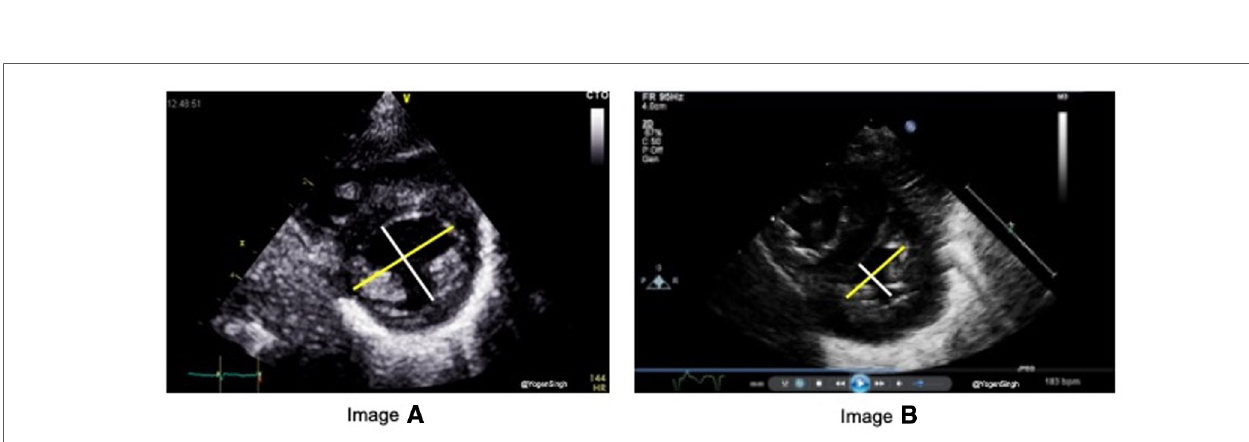
FIGURE 3 End-systolic eccentricity index (EI). EI is obtained by the ratio of left ventricle transverse (yellow line) and vertical (white) diameters at end-systole. Image “ A ” shows normal EI index and image “ B ” shows EI >1.3 in pulmonary